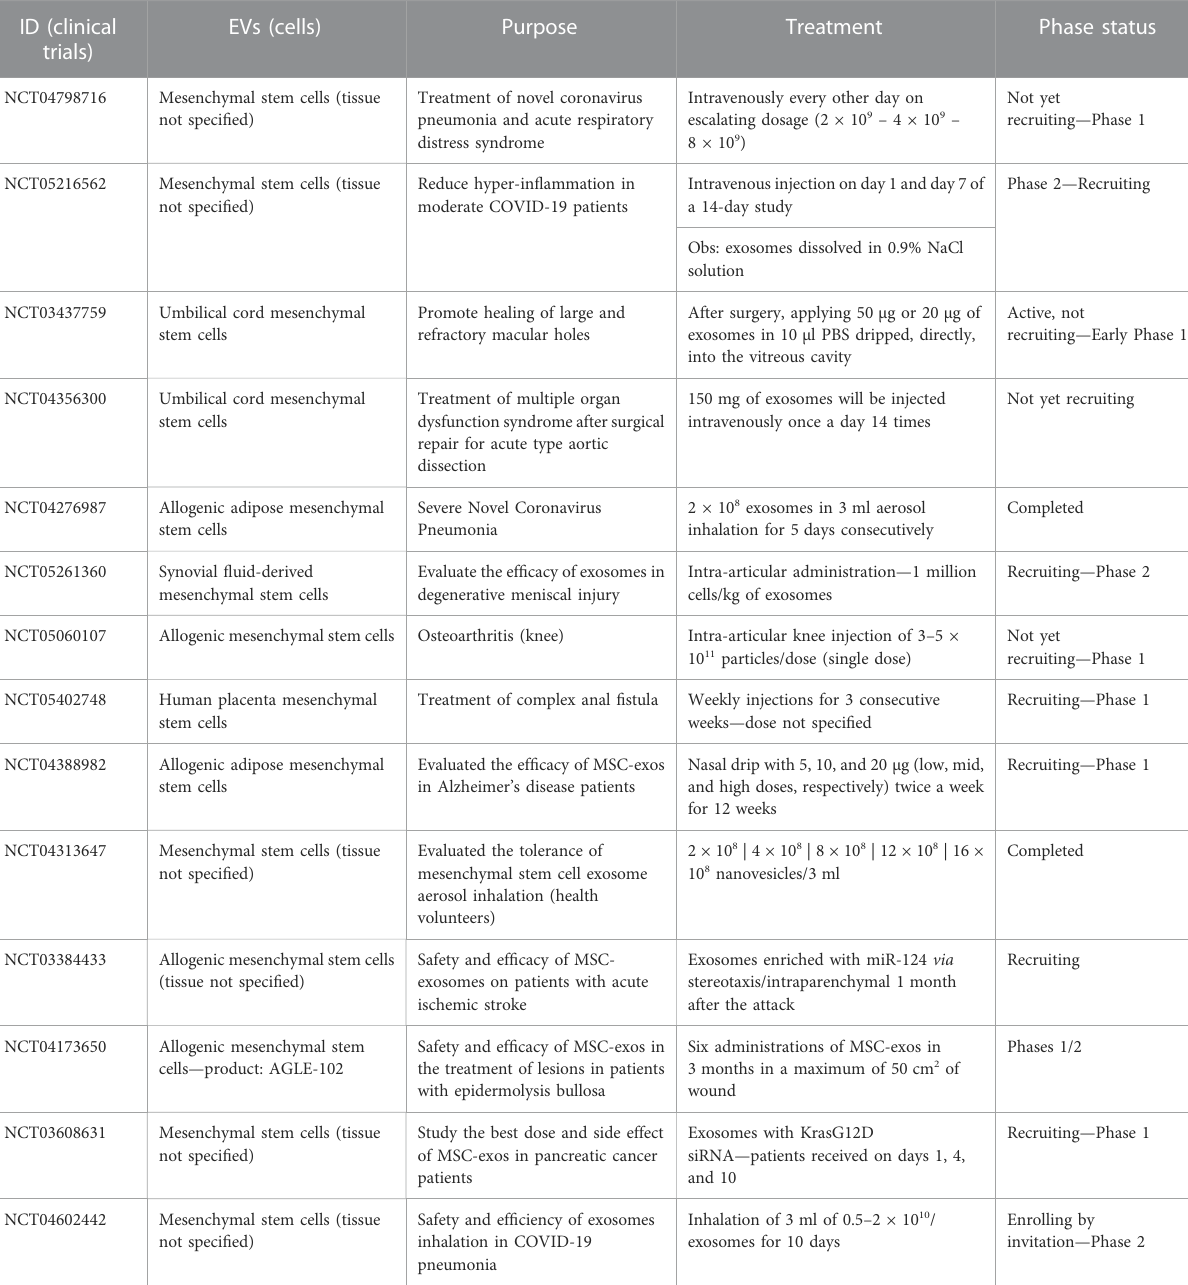
TABLE 3 Active clinical trials undertaken with mesenchymal stem cell-derived Extracellular vesicles in different disease treatments. ID (clinical